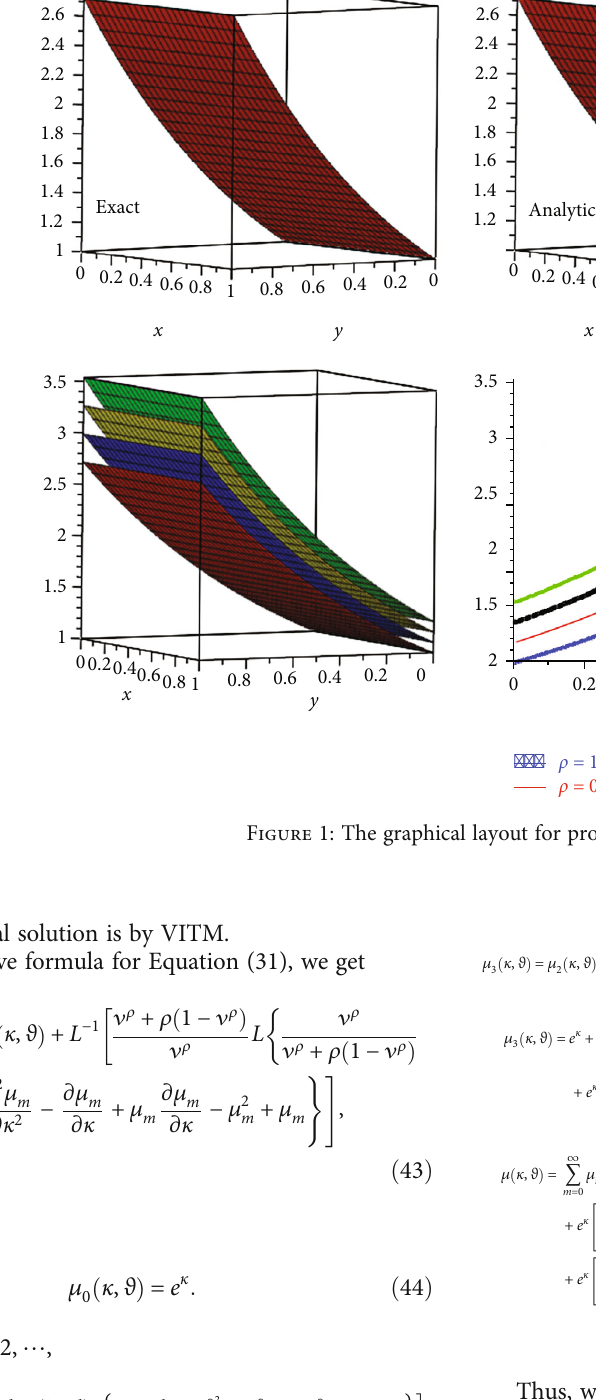
Thus, we get the solution at ρ = 1 as μ ð κ , ϑ Þ = e ð κ + ϑ Þ : At ρ = 1 , the graphs in Figure 1 demonstrate the exact and approximate solutions in ( AB fractional derivative) sense. For example 1 , Figure 1 demonstrates our method ’ s solution for various fractional orders of ρ = 1, 0 : 8, 0 : 6, 0 : 4 and 0 ≤ κ ≥ 1 . Our result is in good agreement with the actual solution, as shown by the graphical illustration. Table 1 also shows a comparison of the exact solution and our approaches solution at various fractional orders using absolute error.